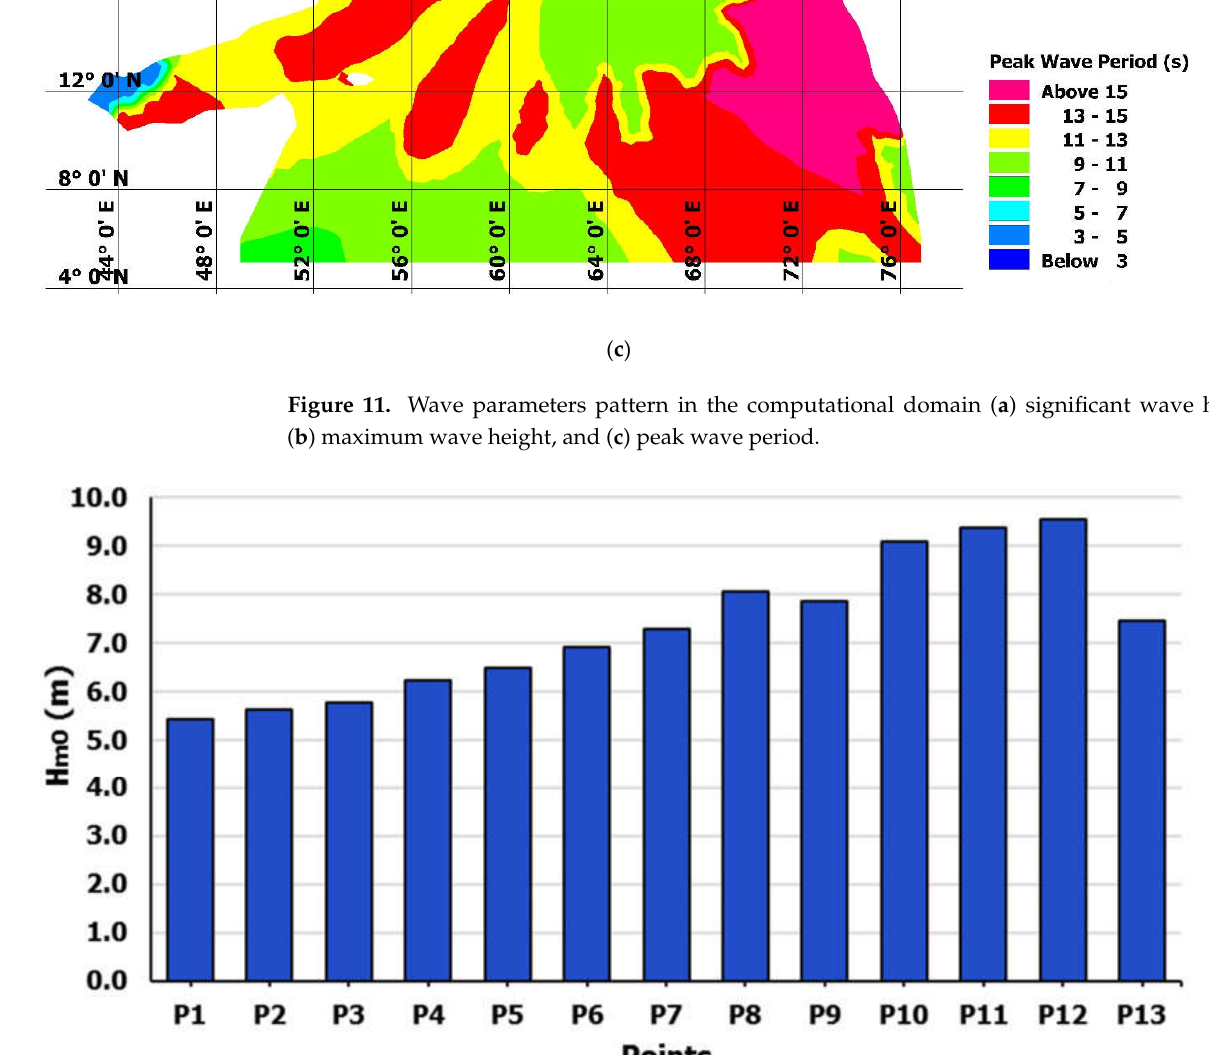
Figure 12. Wave height at optional point along tropical cyclone Kyarr track. Maximum wave heights were derived from the modeling results for the study region throughout tropical cyclone Kyarr (Figure 13). During simulation, the maximum wave height was 19.8 m at 63.188° E, 19.847° N.